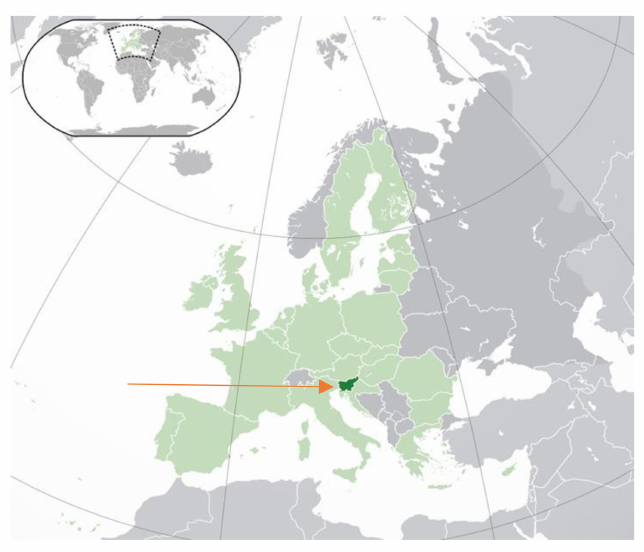
Figure A1. Geolocation of Slovenia [67].